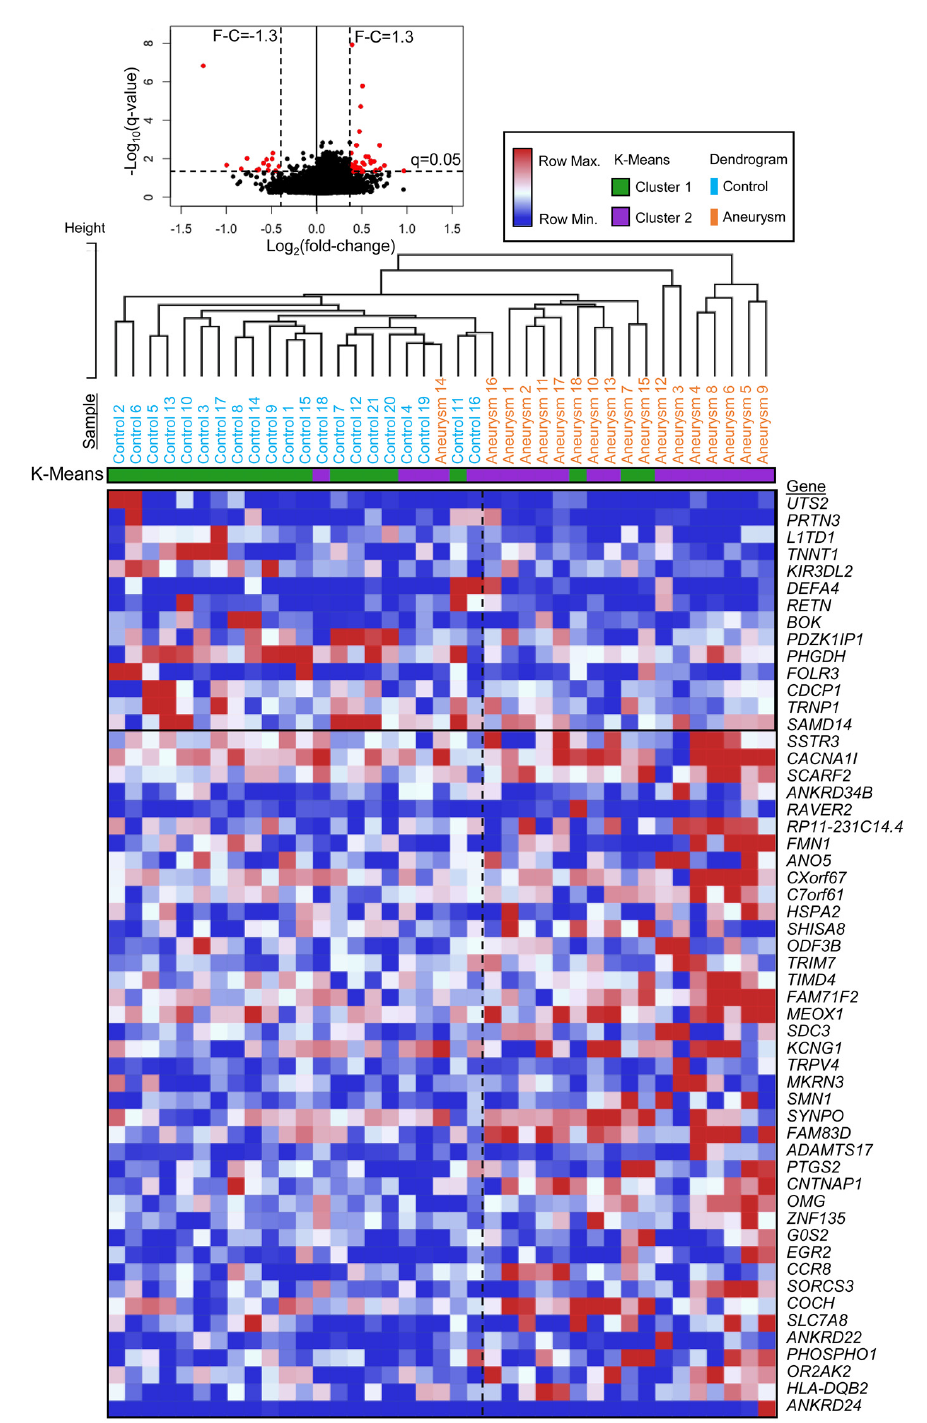
Figure 1. Differential gene expression analysis. The volcano plot at the top demonstrates differential RNA expression between the two groups. Red circles indicate an IA-associated signature of significantly differentially expressed transcripts ( q < 0.05) with an absolute fold-change ≥ 1.3. The heatmap below also shows differential expression of the 54 genes with increasing fold-change (descending). Hierarchical clustering using these 54 genes was able to separate the control (blue) and IA (orange) samples well; K-means clustering showed 85% (33/39) of the samples were clustered their respective group (green with control, purple with IA). (Abbreviations: F-C = fold-change, Max. = maximum, Min. = minimum).